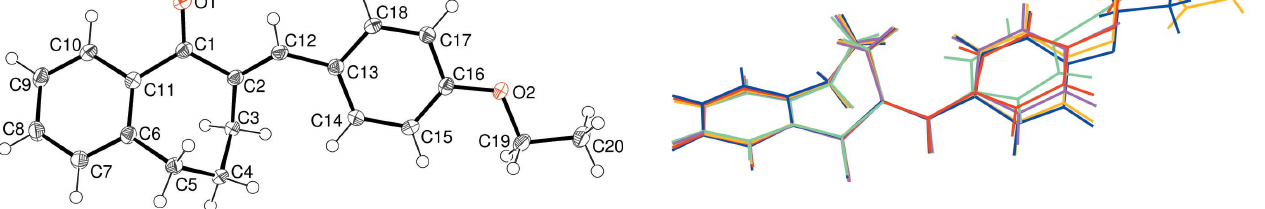
Figure 2 The molecular structure of (II), showing 50% probability displacement ellipsoids.